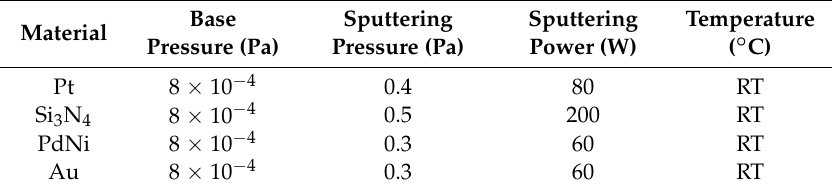
Table 1. Sputtering parameters of different functional film.